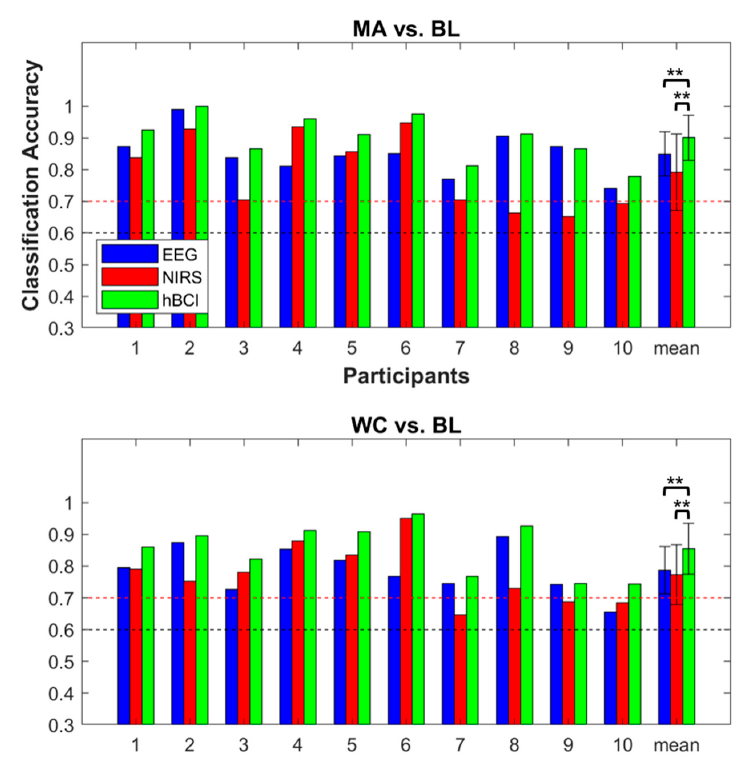
Figure 5. Individual and average offline binary classification accuracies of the EEG (blue), NIRS (red), and hBCI (green) for MA vs. BL ( top ) and WC vs. BL ( bottom ). The error bars indicate the standard deviations of the individual accuracies. The red and black dashed lines are the threshold of the effective binary BCI (>70%) and the theoretical chance level of 60% ( p < 0.05) [38]. The significant difference between the average classification accuracies of the EEG, NIRS, and hBCI are denoted by asterisks (** corrected p < 0.01).